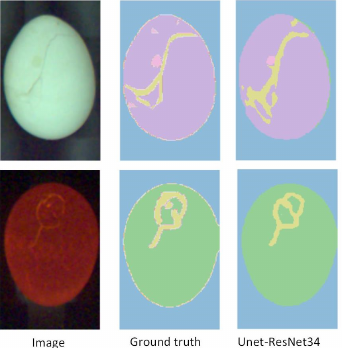
Figure 6. Defect detection samples using semantic segmentation.